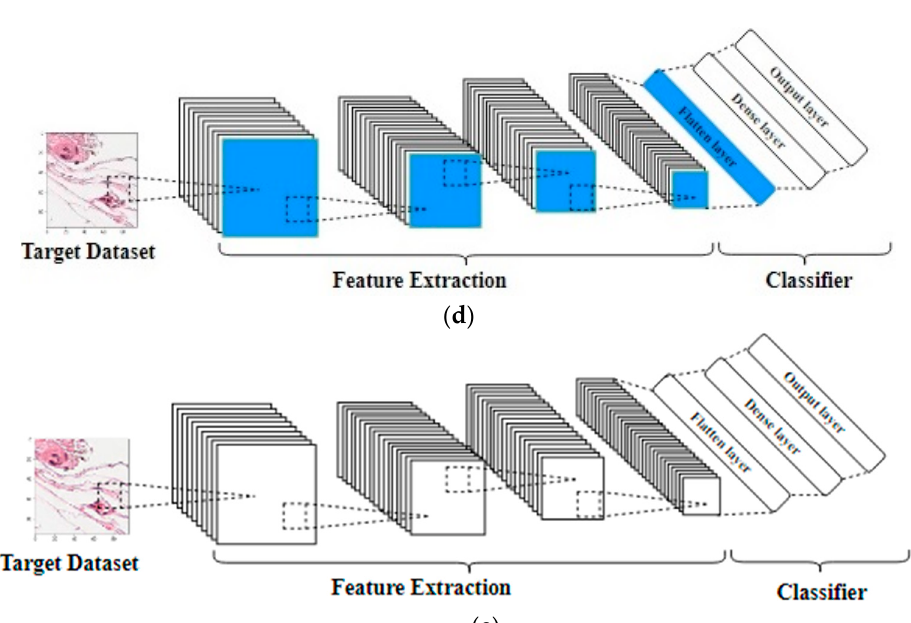
Figure 4. This figure shows different transfer learning techniques: ( a ) a generic CNN trained on ImageNet dataset, ( b ) the first technique, in which the source weights are fixed and the original classifier layers will be replaced by new layers to suit the target dataset, ( c ) the second technique, in which the top layers will be fine-tuned, the weights of the bottom layer will be fixed, and the last fully connected layers will be replaced, ( d ) the third technique, in which the original classifier layers will be replaced and the entire network will be fine-tuned, and ( e ) the fourth technique, in which the original architecture will be used without any weights. The green color represents the weights learned from the ImageNet dataset, the blue color represents the fine-tuning of the ImageNet weights using the target dataset, and the white color means that the weights will be initialized from scratch.